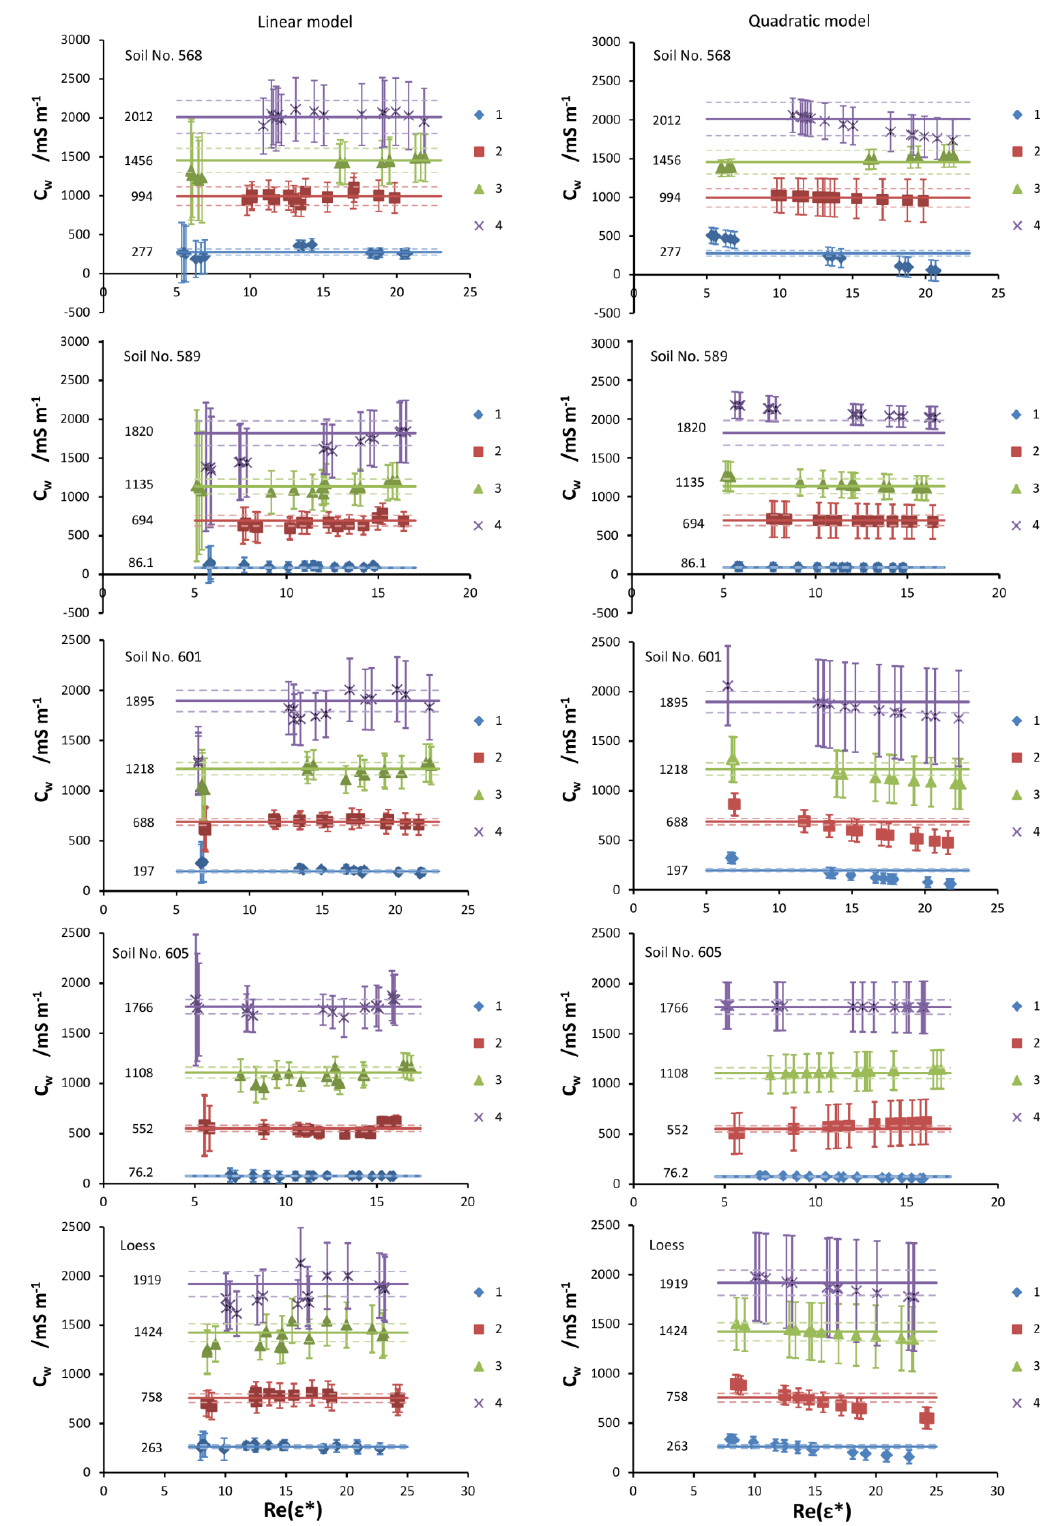
Figure 4. Soil water conductivities (cid:1829) index models for all moistening solutions. Solid lines represent (cid:1829) obtained from the slopes of (cid:1829) the use of (cid:1850) (cid:3020)